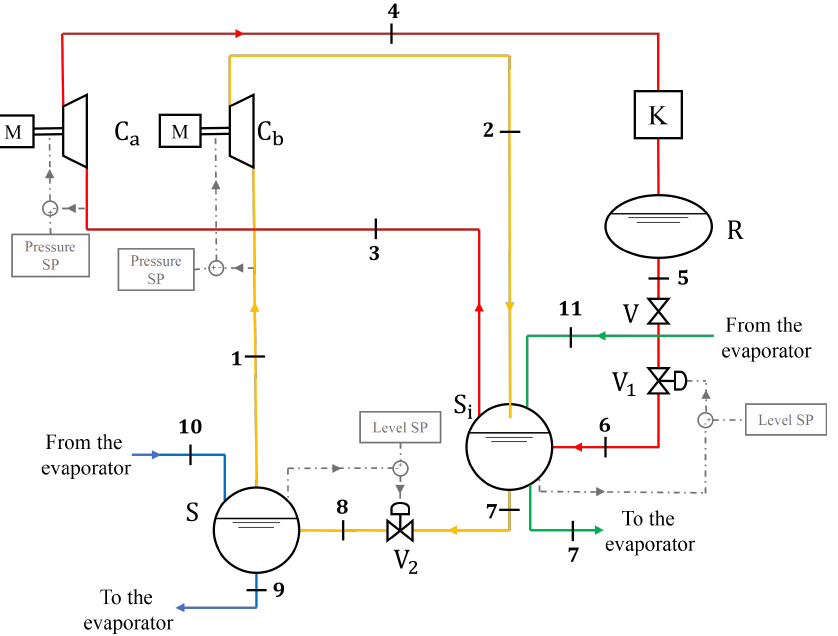
Figure 1. Schematic representation of the refrigeration system